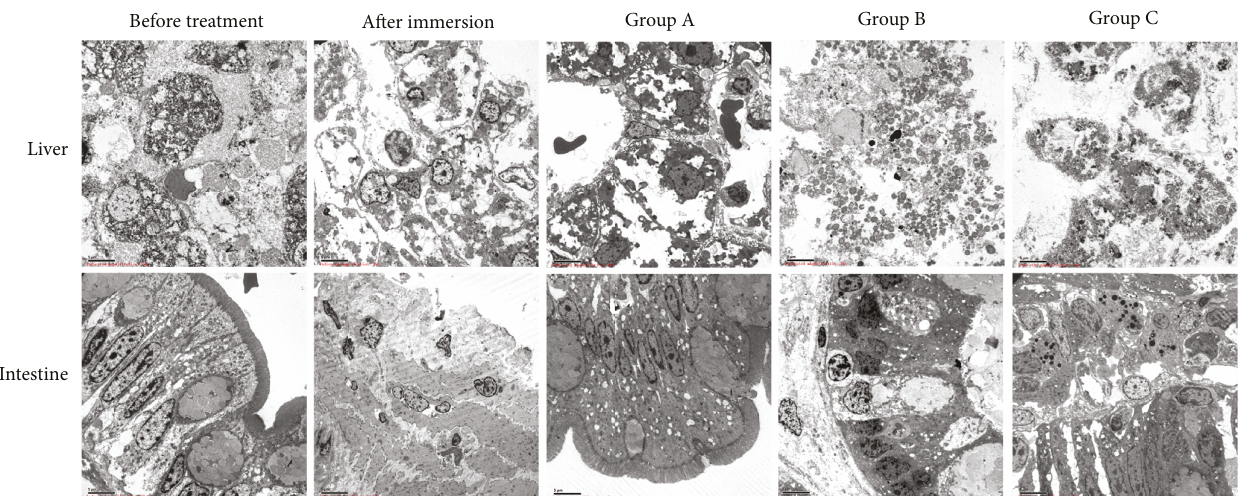
Figure 4: Ultrastructure of the liver, stomach, and small intestine cells in di ff erent treatment groups. Dogs were euthanized at 2h after open abdominal injury, 3 h after the dogs were pulled up from seawater, 2h after delayed lavage (group A), 2h after timely lavage (group B), and 2h after timely lavage with the device (group C). The small intestine and liver tissues were obtained immediately after the dogs were euthanized. After fi xation, embedding and sectioning, the ultrastructure changes of the tissues were observed under a microscope